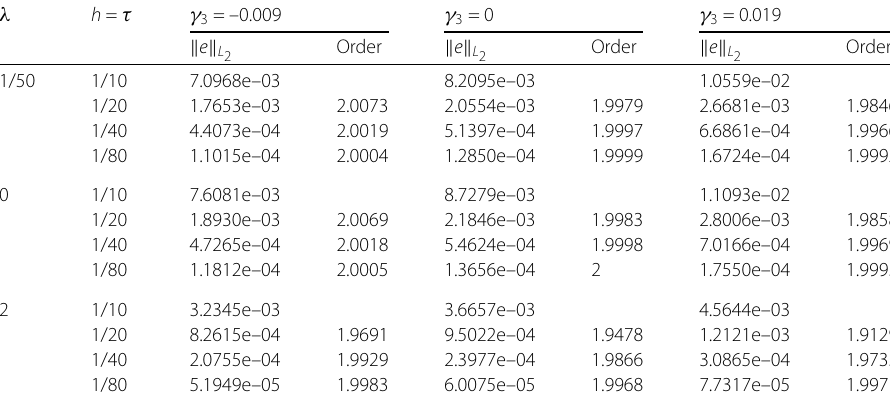
Table 3 Errors and corresponding observation orders at t = 1, α =